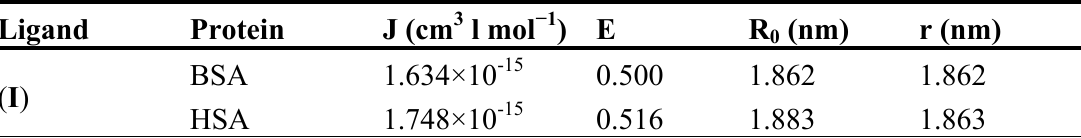
Table 3. Energy transfer parameters: J, the overlap integral; E, the efficiency of energy , the critical distance; r is the distance from the ligand to the tryptophan residue transfer; R 0 of the